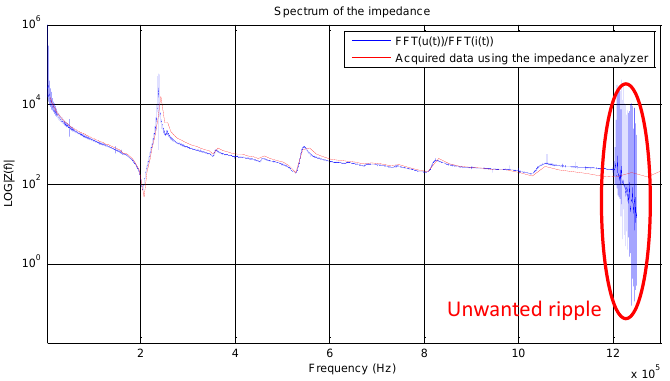
Figure 6. Comparison between the calculated impedance using our experimental setup and the measured one using an Agilent 4294A impedance analyzer. Notice the typical piezoelectric responses at 200 kHz and 240 kHz. It characterizes respectively the resonance and anti-resonance. The unwanted ripples are due to the nature of the spectral response of the applied chirp.